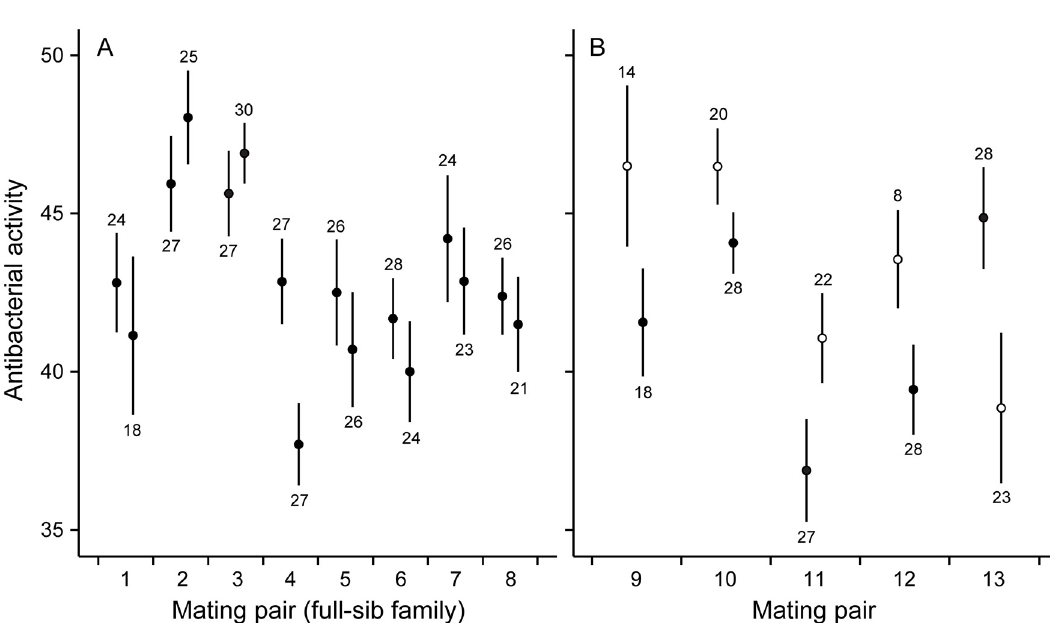
Fig 2. Antibacterial activity (change in optical density over the course of 30 min measured in milliunits) in snail hemolymph. (A) Mean ( ± SE) of individuals produced by different dams in mating pairs of parental snails in which both dams reproduced through outcrossing (individuals produced by each pair are full-sibs). (B) Mean ( ± SE) of individuals produced by different dams in mating pairs in which one dam reproduced through self-fertilization (open